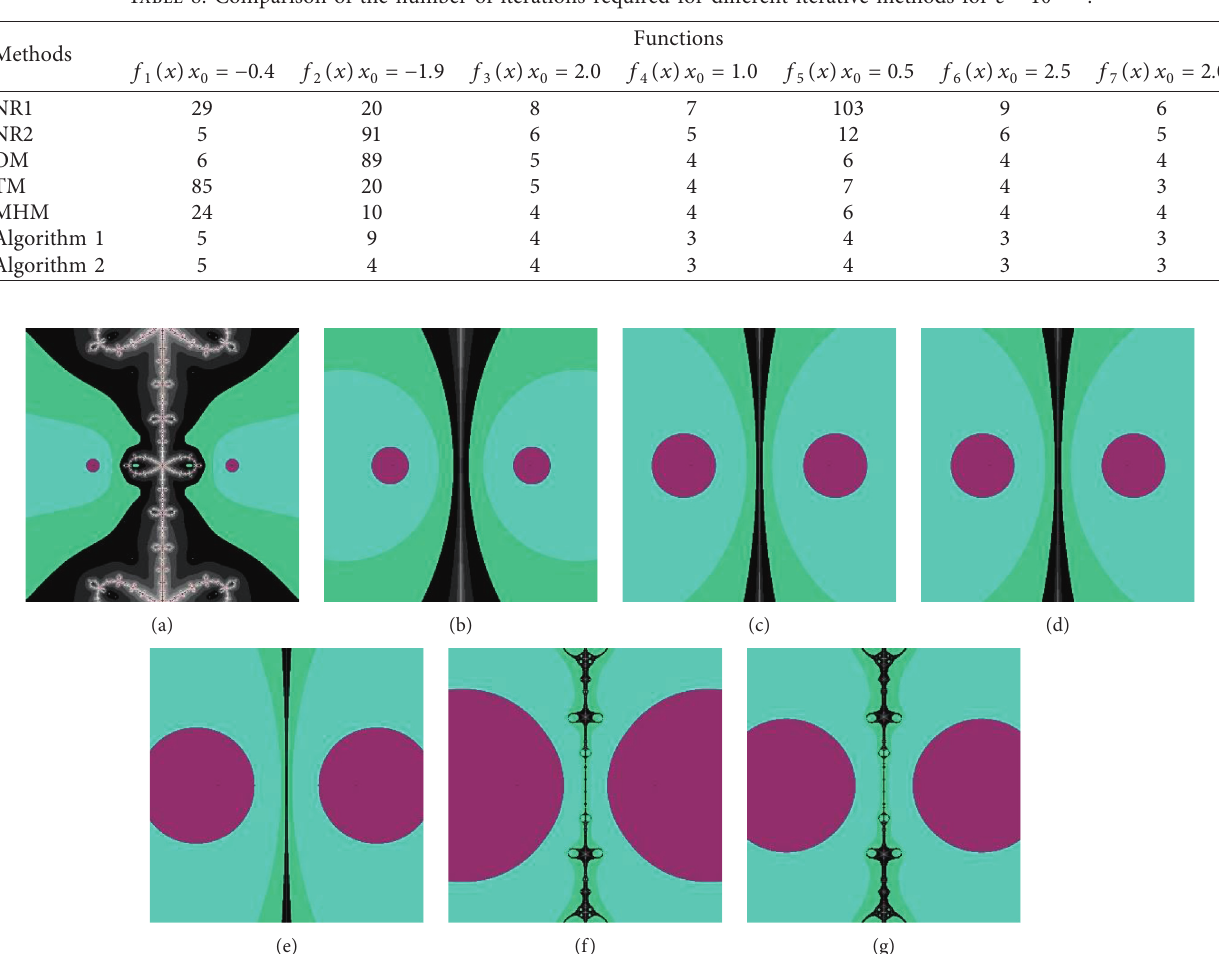
( z ) using various iterative methods. (a)Polynomiograph for the polynomial p 1 ( z ) using NR2. (c) Polynomiograph for the polynomial p 1